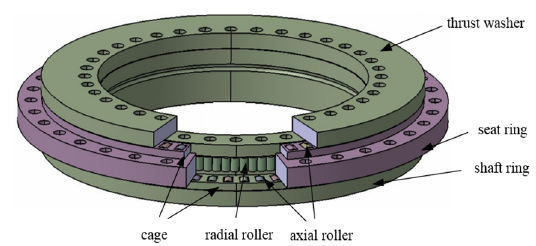
Figure 2. Bearing structure diagram of the YRT turntable bearing.